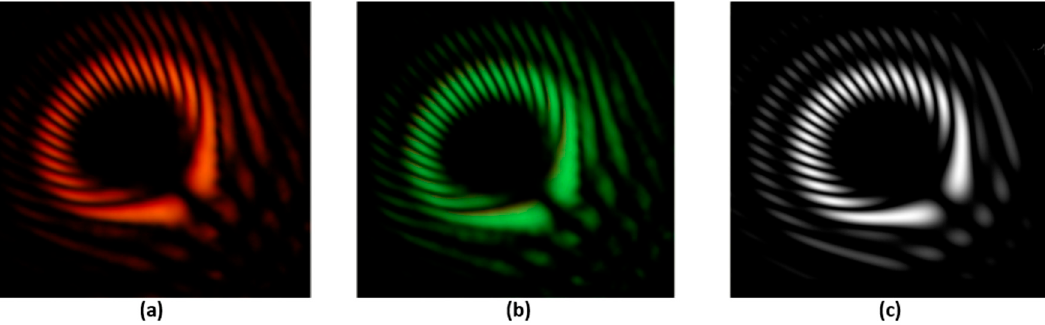
Figure 10. Interference from oppositely charged vortices ( m = 10 and m = − 10), ( a ) red vortex interference, ( b ) green vortex interference, and ( c ) numerical prediction from the IDL code.